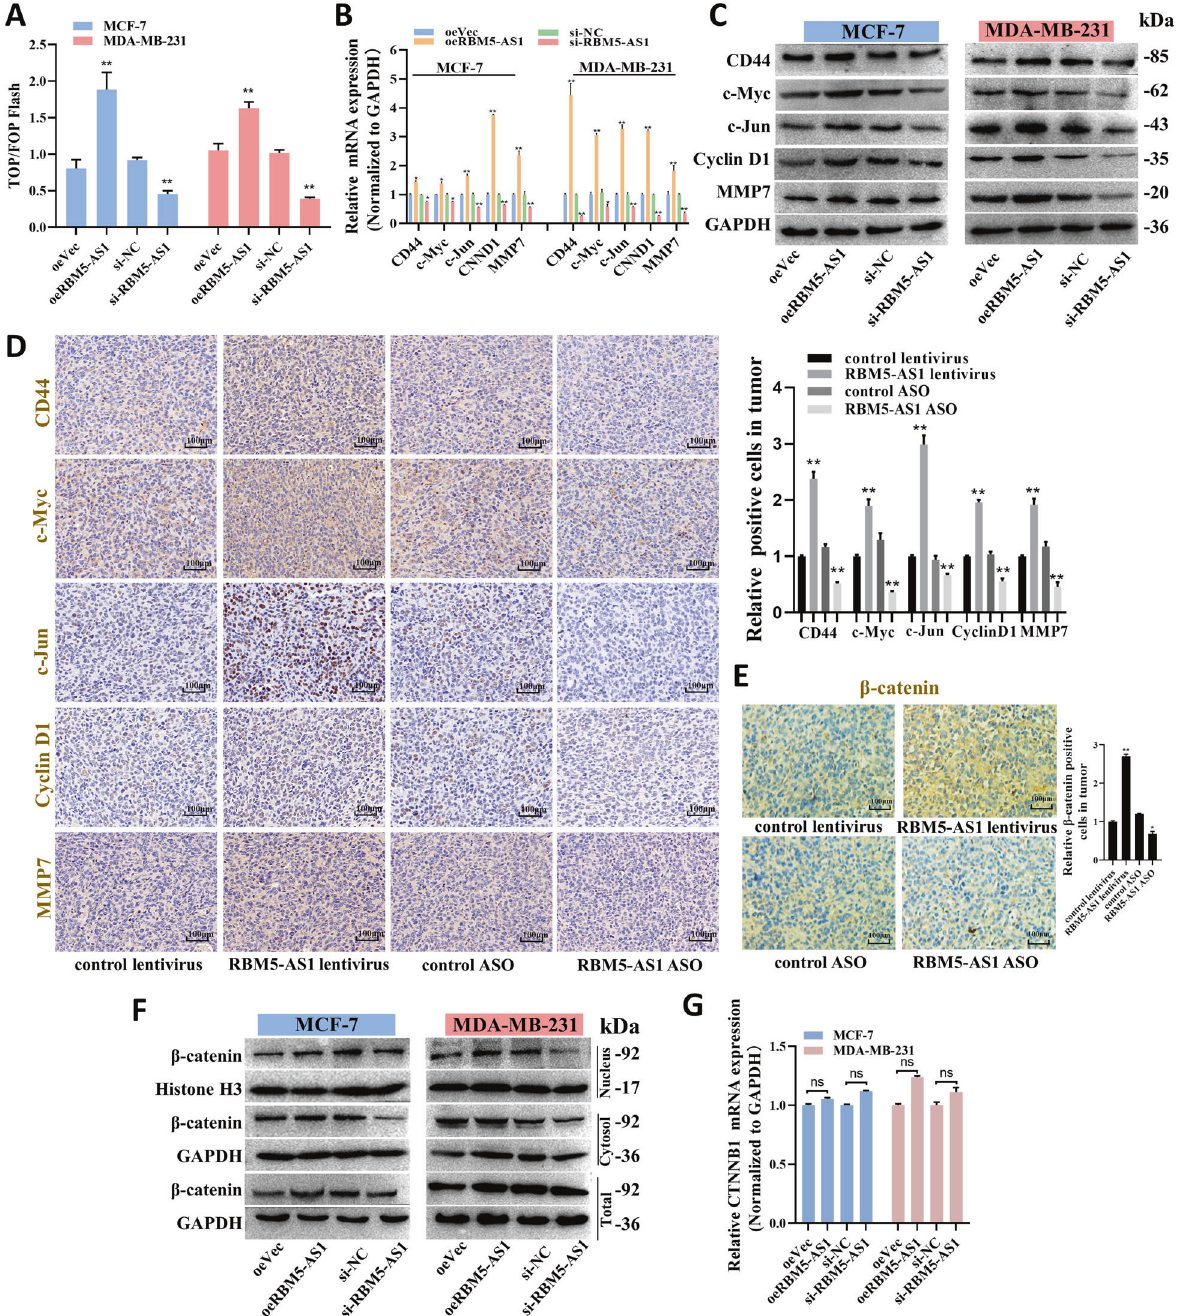
Fig. 5 RBM5-AS1 activates Wnt/ β -catenin signaling and upregulates β -catenin protein levels in breast cancer cells. A The activation of the WNT/ β -catenin signaling was evaluated using a TOP/FOP fl ash assay. mRNA ( B ) and protein ( C ) levels of genes downstream of Wnt signaling in oeVec, oeRBM5-AS1, si-NC, or si-RBM5-AS1 transfected MCF-7 and MDA-MB-231 cells. D Representative IHC images of Wnt signaling proteins in mice tumor sections. Scale bar, 100 μ m. E Representative IHC images of β -catenin in mice tumor sections. Scale bar, 100 μ m. F Protein levels of β -catenin in the nuclei, cytosol, and whole cells in oeVec, oeRBM5-AS1, si-NC, or si-RBM5-AS1 transfected MCF-7 and MDA-MB-231 cells. G mRNA levels of β -catenin (CTNNB1) in oeVec, oeRBM5-AS1, si-NC, or si-RBM5-AS1 transfected MCF-7 and MDA-MB-231 cells. All data are shown as the mean ± SEM. * P < 0.05 and ** P < 0.01 by two-tailed Student ’ s t